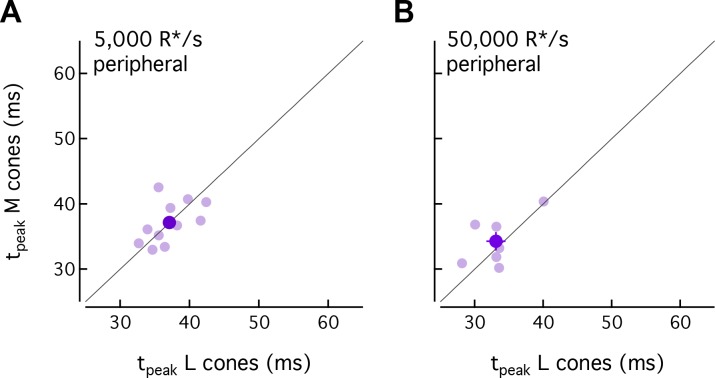
Kinetics of L- and M-cone flash responses are similar.(A) Average time to peak of L cones (n = 29) compared to average time to peak of M cones (n = 26) in peripheral retina on a background of 5000 R*/s. Each light purple point represents the average times to peak from a single piece of retina. The dark purple point with error bars represents mean ±sem across all pieces. (B) As in panel A for data collected on a background of 50,000 R*/s, 17 M cones and 42 L cones.